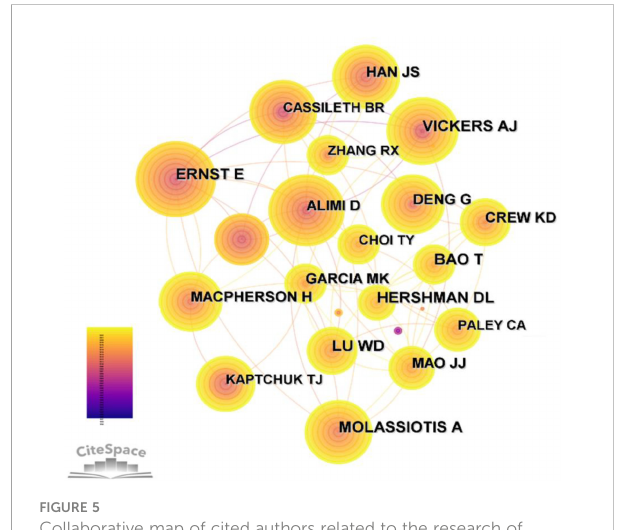
FIGURE 5 Collaborative map of cited authors related to the research of acupuncture for cancer pain.